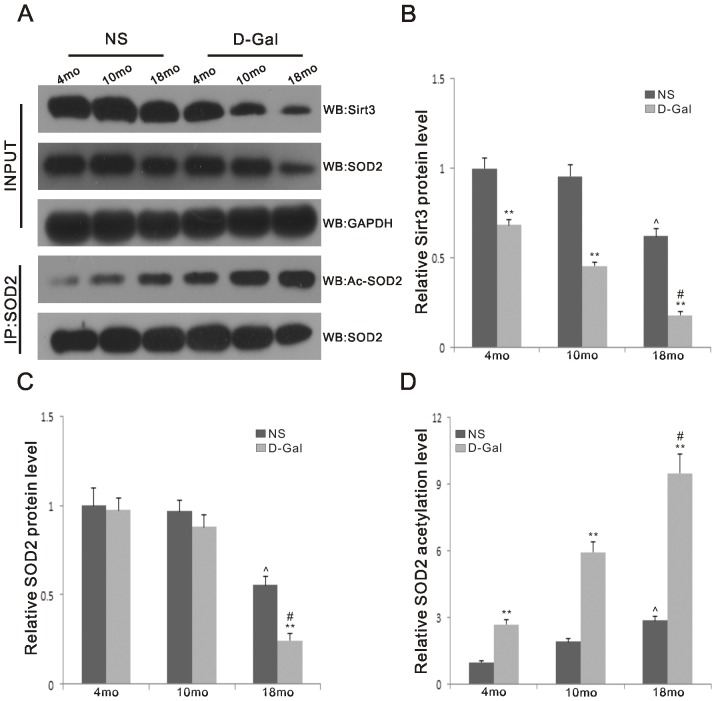
Physical interaction between SOD2 and Sirt3 in the auditory cortex.A. Endogenous SOD2 was immunopurified from the auditory cortex with anti-SOD2 antibody, followed by western blotting with anti-SIRT3, anti-Sirt4 and anti-Sirt5 antibodies. B. Endogenous Sirt3 was immunopurified from the auditory cortex with anti-Sirt3 antibody, followed by western blotting with anti-SOD2, anti-SOD1 and anti-SOD3 antibodies.